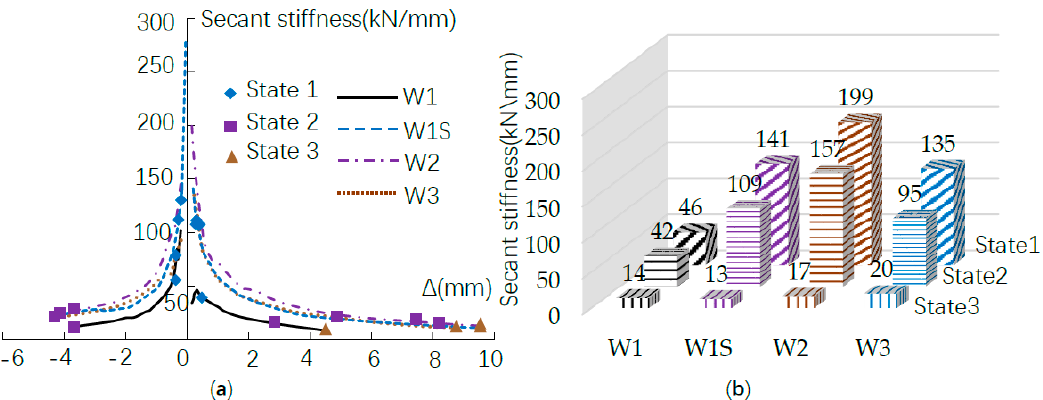
Figure 9. Stiffness degradation: ( a ) Stiffness degradation during the loading procedures; ( b ) stiffness Figure 9. Sti ff ness degradation: ( a ) Sti ff ness degradation during the loading procedures; ( b ) sti ff ness at at typical states. typical